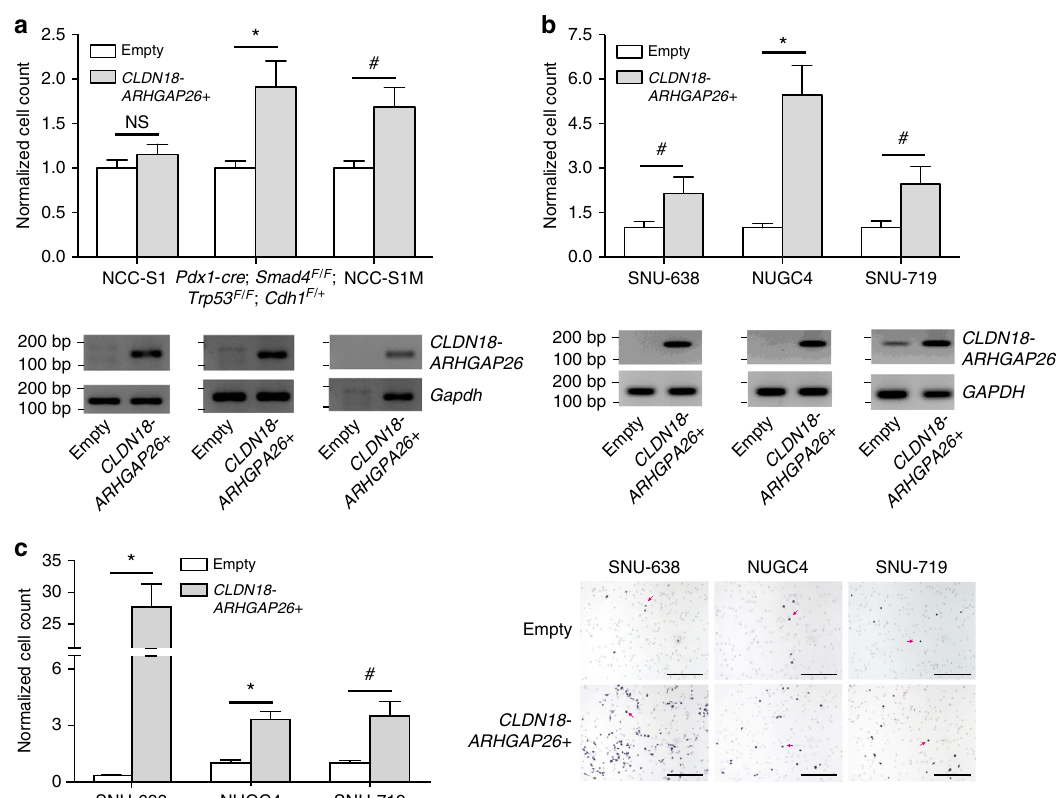
Fig. 5 Functional effects of CLDN18-ARHGAP26 overexpression ( a ) Top, Trans-well migration assay. Mouse gastric cancer cells stably expressing CLDN18- ARHGAP26 demonstrated signi fi cantly enhanced migration ability compared with those expressing an empty vector (P < 0.001, Wilcoxon signed rank), and this effect was prominent in NCC-S1M and Pdx1-cre;Smad4 F/F ; Trp53 F/F ; Cdh1 F/ + cells. Vertical axis denotes the normalized number of migrated cells per fi eld. Average values of 4 independent experiments; Bottom, RT-PCR for CLDN18-ARHGAP26 ( b ) Top, Migration assay of human gastric cancer cells following the ectopic expression of CLDN18-ARHGAP26 . Human gastric cancer cells stably CLDN18-ARHGAP26 demonstrated signi fi cantly enhanced migration capacity compared with those expressing an empty vector (P < 0.001, Wilcoxon signed rank). Vertical axis denotes the normalized number of migrated cells per fi eld. Average values of 3 independent experiments; Bottom, RT-PCR for CLDN18-ARHGAP26 . ( c ) Left, Invasion assay. Human gastric cancer cells stably expressing CLDN18-ARHGAP26 demonstrated signi fi cantly enhanced invasion capacity compared with those expressing an empty vector (P < 0.001, Wilcoxon signed rank). Vertical axis denotes the normalized number of migrated cells per fi eld. Average values of three independent experiments. Right, Representative photographs of the invasion assay (200 × , scale bar = 0.2 mm). Red arrows, gastric cancer cells. Error bars, mean ± SEM. # P < 0.05, *P < 0.01, **P < 0.001, ***P <